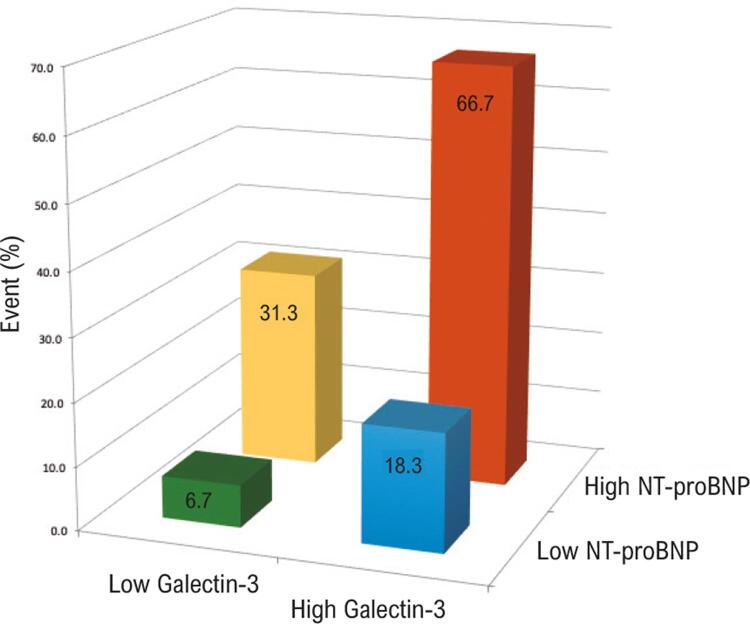
– Event frequency at 5-year as a function of Gal-3 and NT-proBNP concentrations among CC patients. The percentage of patients who experienced any event is shown for each group. Low Gal-3: values <15.3 ng/mL; high Gal-3: values ≥15.3 ng/mL; low NT-proBNP: values <1,278 pg/mL; high NT-proBNP: values ≥1,278 pg/mL.